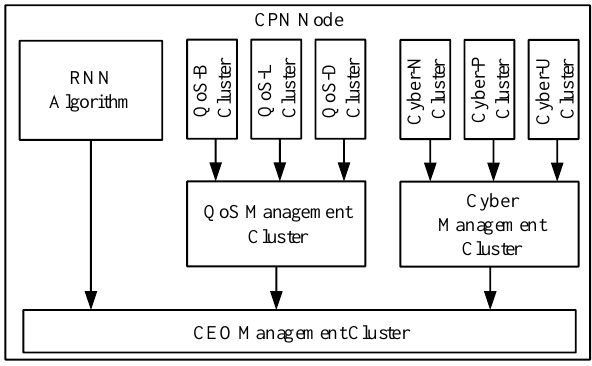
Figure 6. Deep Learning Cluster Structure.